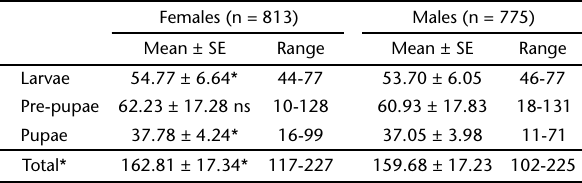
Table III. Agrotis malefida reared under controlled conditions (25 ± 1°C, 70 ± 10% RH and 14 hours photophase). Mean duration (days), and standard errors, of larval and pupal periods, considering males and females separately. The prepupal period is separated from the larval period. The mean values of both sexes were compared using a t-test, at a confidence level of 95%.